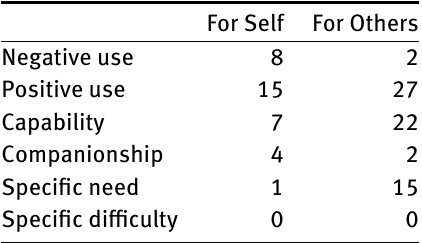
Table 10: Co-occurrences of Everyday experience by